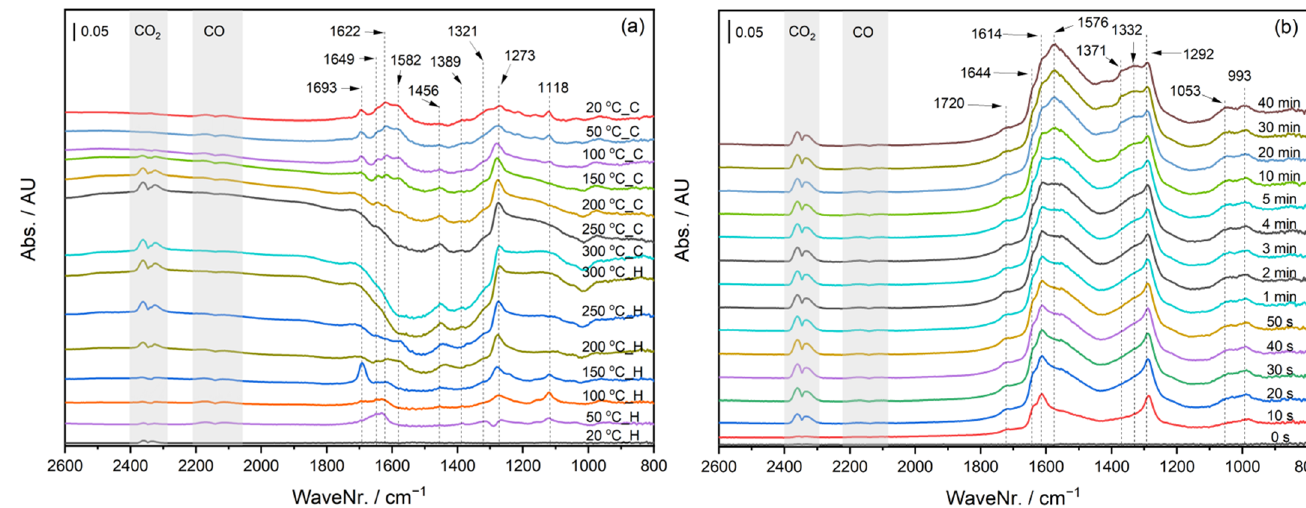
Figure 6. ( a ) DRIFTS spectra of sample x = 0.25 exposed to the reaction mixture of 0.2% CO + 2% O 2 balanced in He, after a He-treatment at 150 °C during a transient experiment ( b ) DRIFTS spectra of sample x = 0.25 exposed to the reaction mixture of 0.2% CO + 2% O 2 balanced in He, after an oxidative treatment during 40 min of steady-state condition at 200 °C.